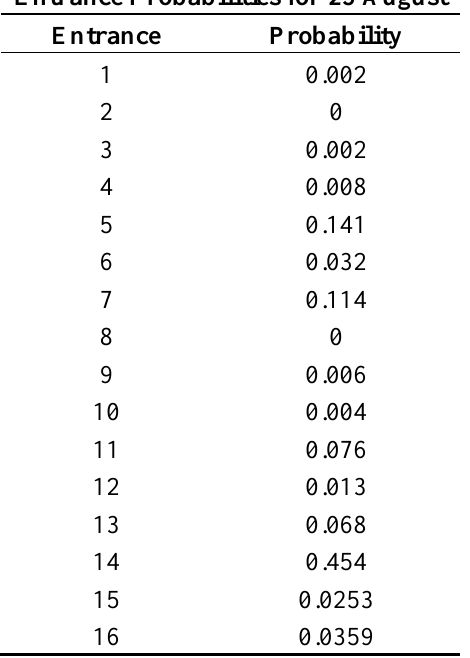
Table 1. Entrance probabilities for each entrance derived from scene